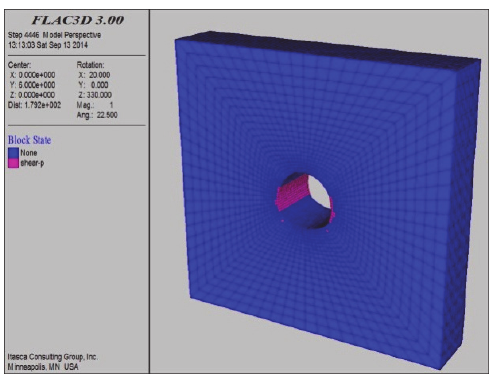
Figure 11: 3d traditional support plastic zone. Figure 12: 3d new support plastic